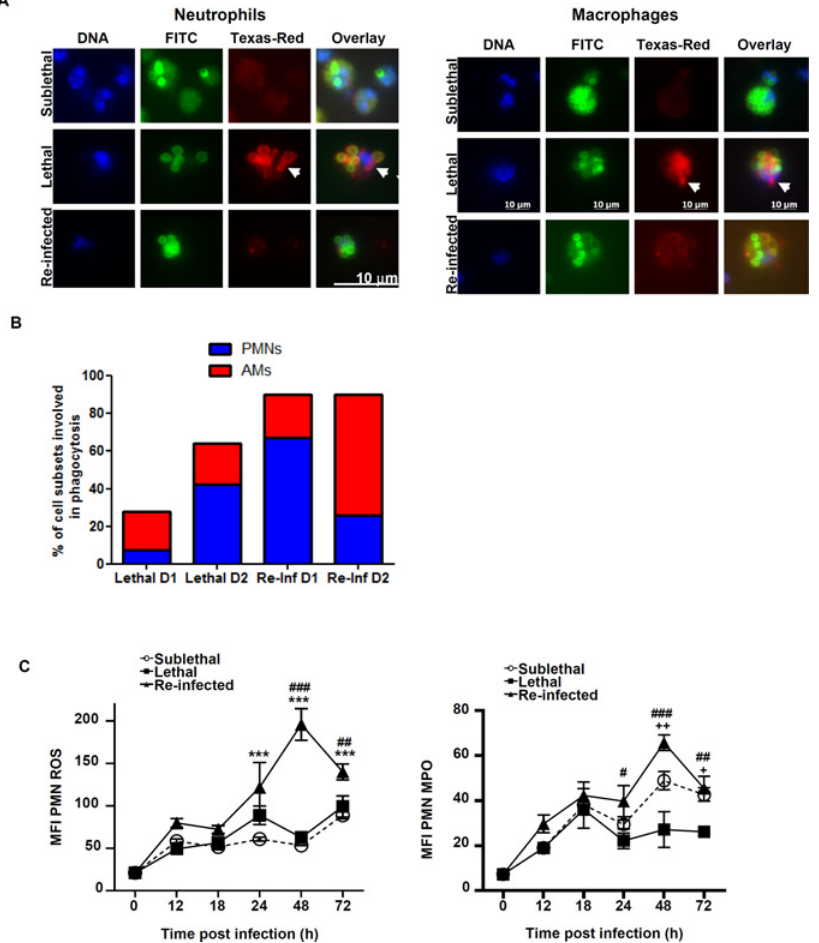
Fig 4. Phagocytes from protected mice internalize and kill the conidia efficiently. Mice were either infected at day 0 with a sublethal (SL) or a lethal (L) concentration of A . fumigatus conidia. Re-infected (Re- Inf) mice were first infected with a SL dose and 10 days later were challenged with the L dose. (See S1 Fig). (A) Representative pictures showing phagocytosis of conidia by BAL neutrophils (left panel) and macrophages (right panel) in the three infection settings at 48 h post infection. Mice were infected with FITC (green) labelled conidia, and the non-phagocytosed conidia were stained using an anti-conidia antibody detected by a secondary Texas Red-conjugated antibody (red). DNA was labelled with Hoechst stain (blue). Using fluorescence microscopy, the phagocytosed conidia were detected only in green while the outside FITC and Texas red conidia appear in yellow. Germination was indicated by the arrowheads pointing to non- phagocytozed and germinating conidia and to piercing hyphae (in red). The percentage of phagocytosis was estimated as the ratio of the number of ingested conidia to the total number of conidia bound to 100 phagocytes (B) Percentages of neutrophils (PMNs) and alveolar macrophages (AMs) involved in the phagocytosis in the lethal and re-infected groups at D1 and D2 h p.i. Within each histogram, is represented the percentage of either neutrophils or alveolar macrophages participating to the phagocytosis (C) BALs were collected and analyzed by flow cytometry to evaluate the killing potential. Plots are gated on GR1 high CD11b + neutrophils and show expression level of the ROS (left panel) and MPO (right panel) production. Data (mean ± SEM) represent 2 to 3 independent experiments with 5 mice per experiment. Statistically significant differences were determined using a Two way ANOVA with Bonferroni post-test (+p < 0.05, ++p < 0.01, ++ +p < 0.001 L dose vs SL dose; * p < 0.05, ** p < 0.01, *** p < 0.001 Re-Inf vs SL dose; #p < 0.05, ###p < 0.001 LL dose vs Re-Inf